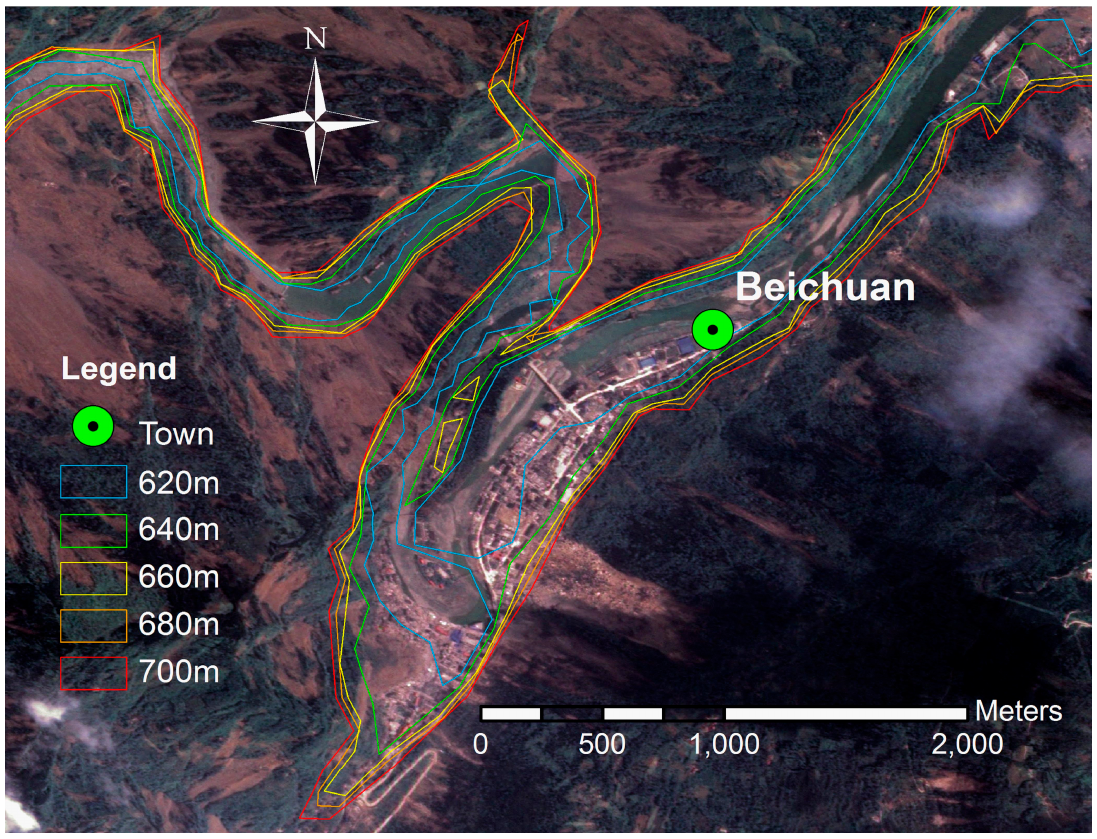
Figure 9. Potential impact area of dammed lake downstream ( H = 700, 680, 660, 640, 620 m).